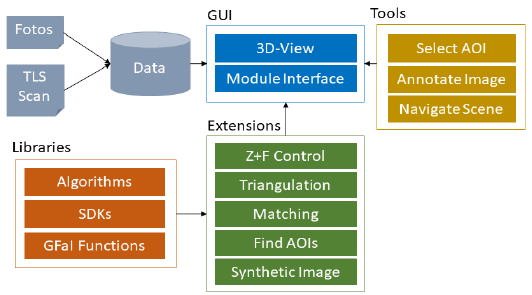
Figure 2. Design of demonstrator application.